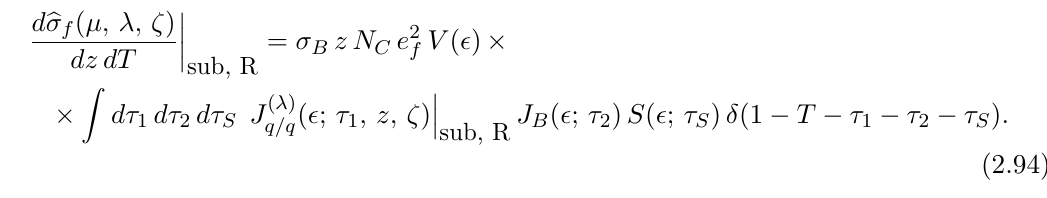
Figure 5 . Factorization of the partonic final state tensor c W µν can be computed in perturbation theory. All terms appearing in eq. (2.89) can easily be recognized: the virtual vertex V ( (cid:15) ) = V V ? , the soft thrust function S ( (cid:15) ; τ ) = S , the backward thrust function J B ( (cid:15) ; τ ) = J B and the jet thrust function equipped with the subtraction mechanism described in section